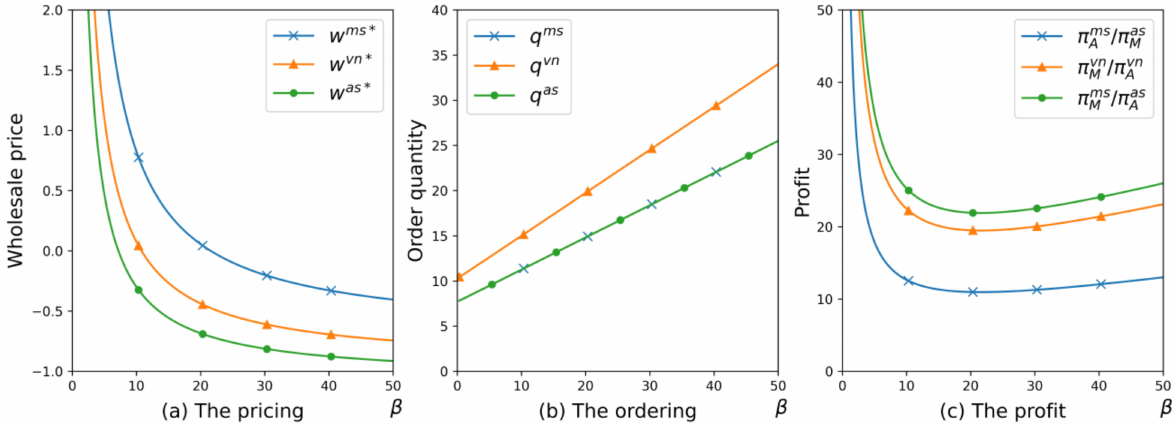
Figure 3. Impact of the consumer’s price sensitivity coefficient when the price sensitivity coefficient is high: ( a ) impact of the consumer’s price sensitivity coefficient on the pricing; ( b ) impact of the consumer’s price sensitivity coefficient on the ordering; ( c ) impact of the consumer’s price sensitivity coefficient on the